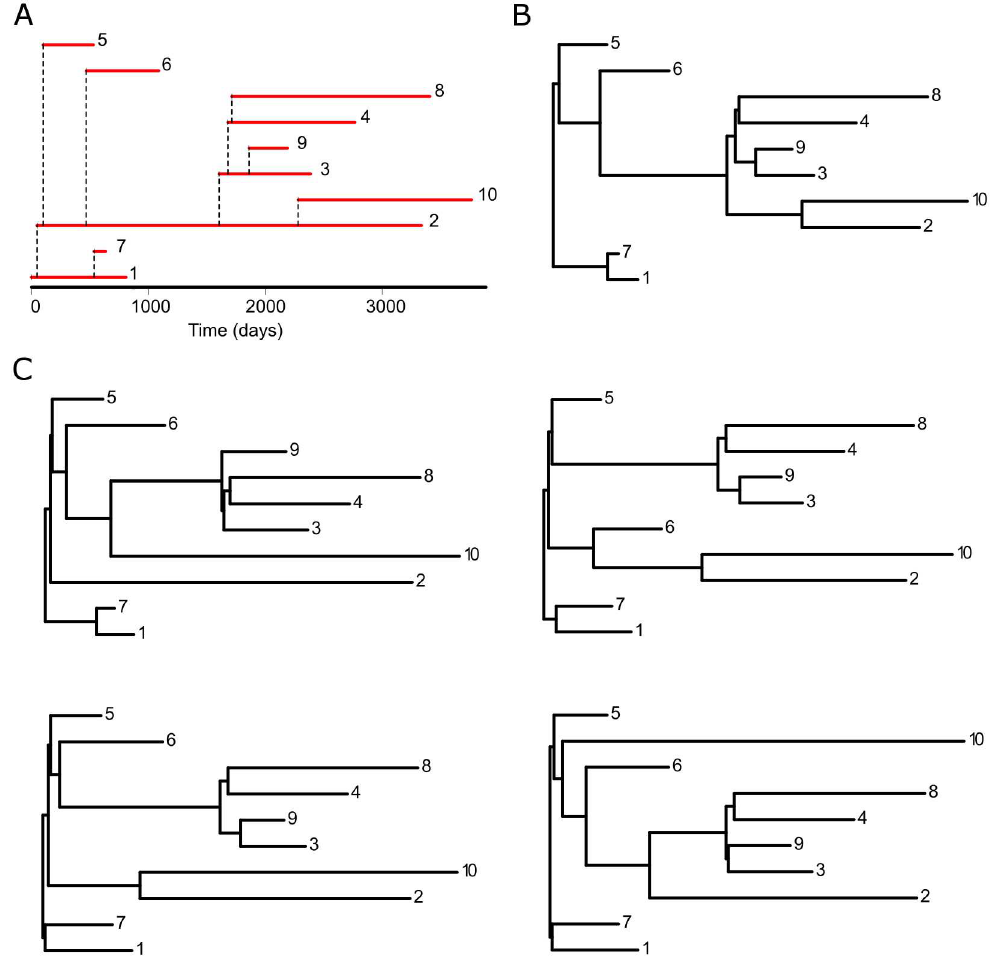
Fig 2. Relationship among transmission history, transmission tree and virus genealogy. For a given transmissionhistory betweenhosts (A), we can construct a binary representation, i.e. the transmission history (B). The lower panels (C) show 4 possiblevirus genealogies of this transmissionhistory invokingour within-host populationmodel.